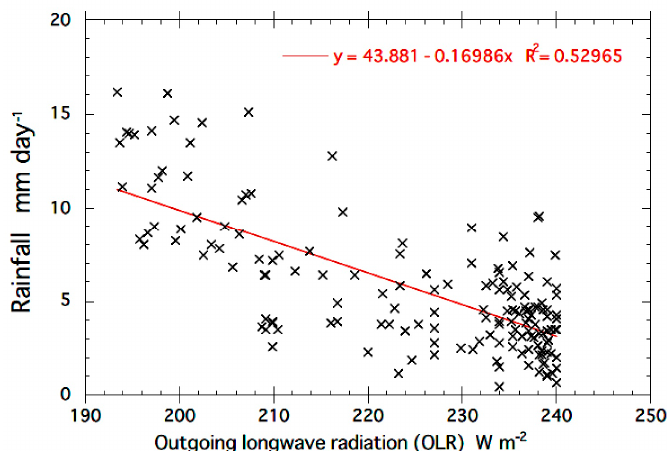
Figure 5. Averaged rainfall (TRMS) and OLR.